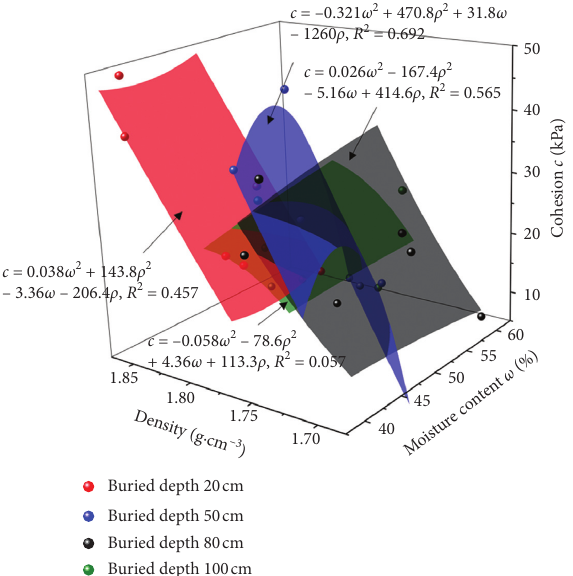
Figure 10: Relationship between cohesion at different depths and density and water content. (e) Partial collapse stage (Figure 13(e)): with the contin- uation of evaporation-rainfall, the width, length, number, and depth of the cracks in the evaporation stage are further developed, extending the gully to the middle and lower part of the fracture surface. During the rainfall phase, the rainwater flows down the original gullies and runs through to the foot of the slope. When the rainfall intensity is high, when the original slope shoulder gully cannot bear the flow, rainwater will flow